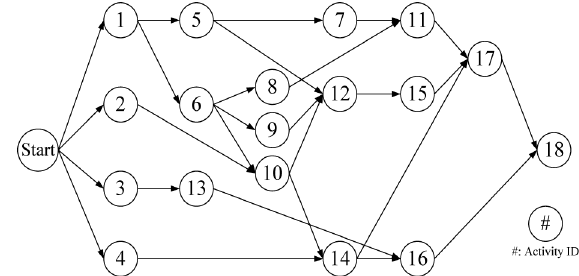
Fig. 6. Network of